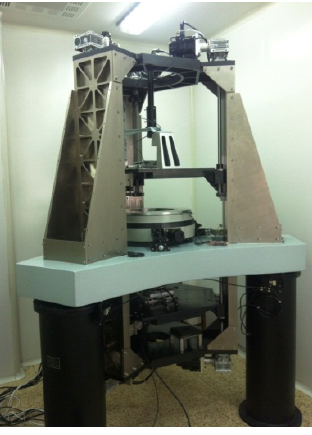
Fig. 8 Experimental lateral shearing interferometer.